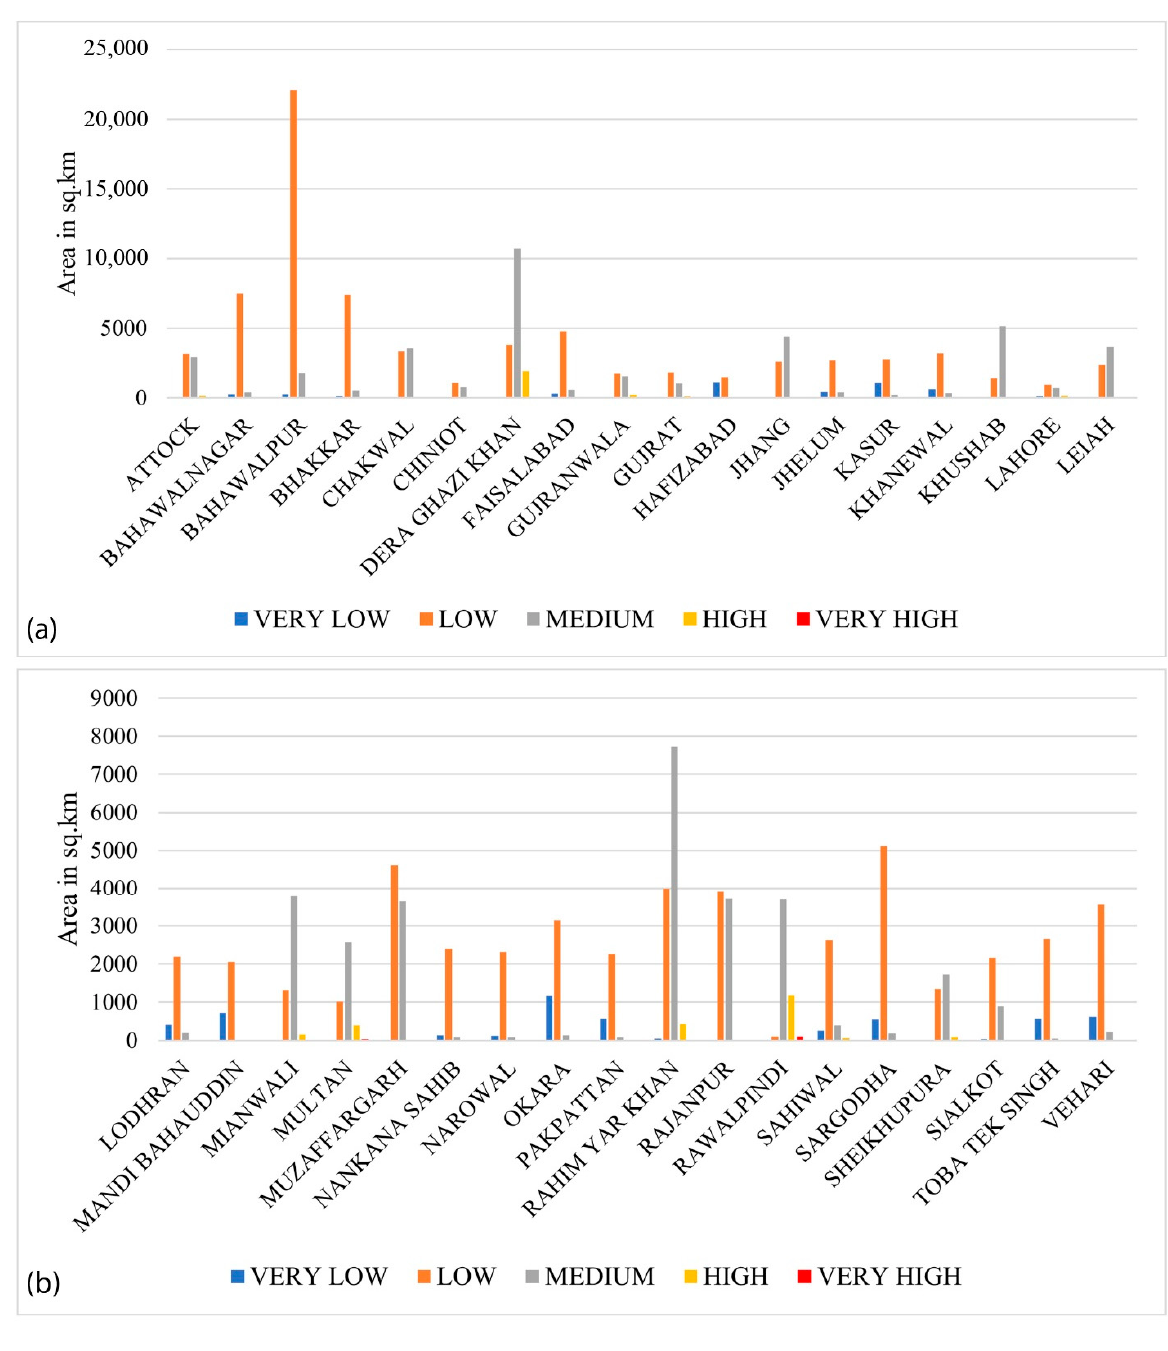
Figure 7. Area-wise EVA results for district of Punjab province: ( a ) 1–18 districts; ( b ) 19–36 districts.